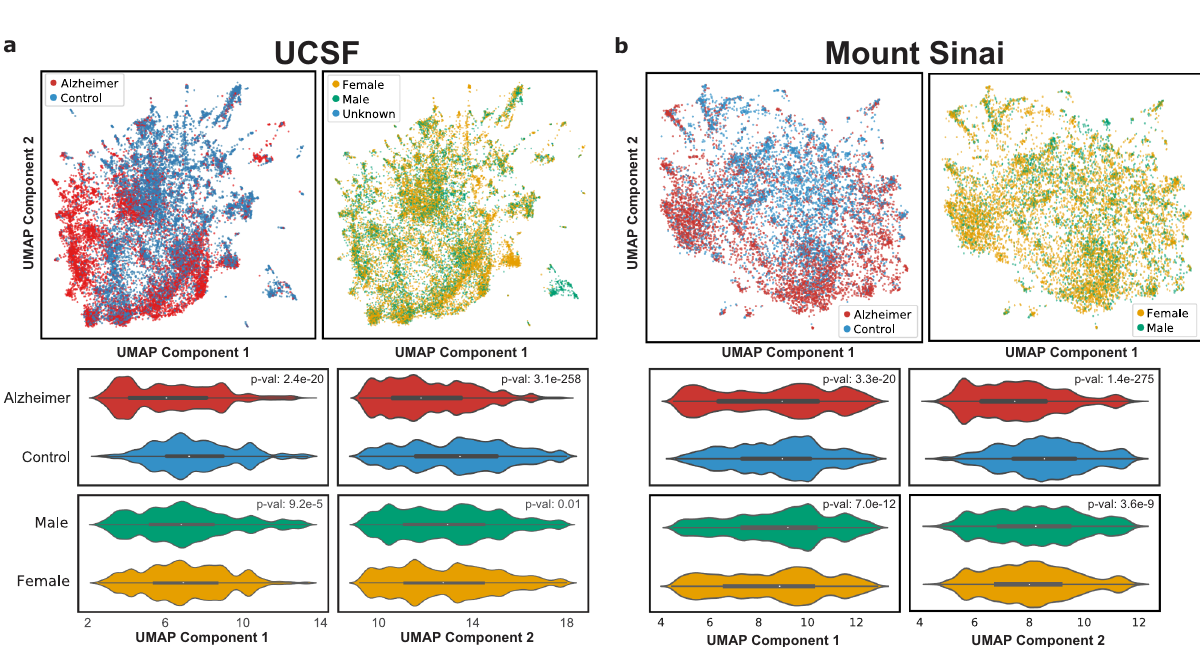
Summary table of sex, estimated age, death status, and fi rst race among Alzheimer ’ s and control cohorts at UCSF and Mount Sinai. Patients are propensity score-matched at a 1:2 Alzheimer to control ratio with the demographics shown in the table. SD standard deviation, SMD standardized mean difference.